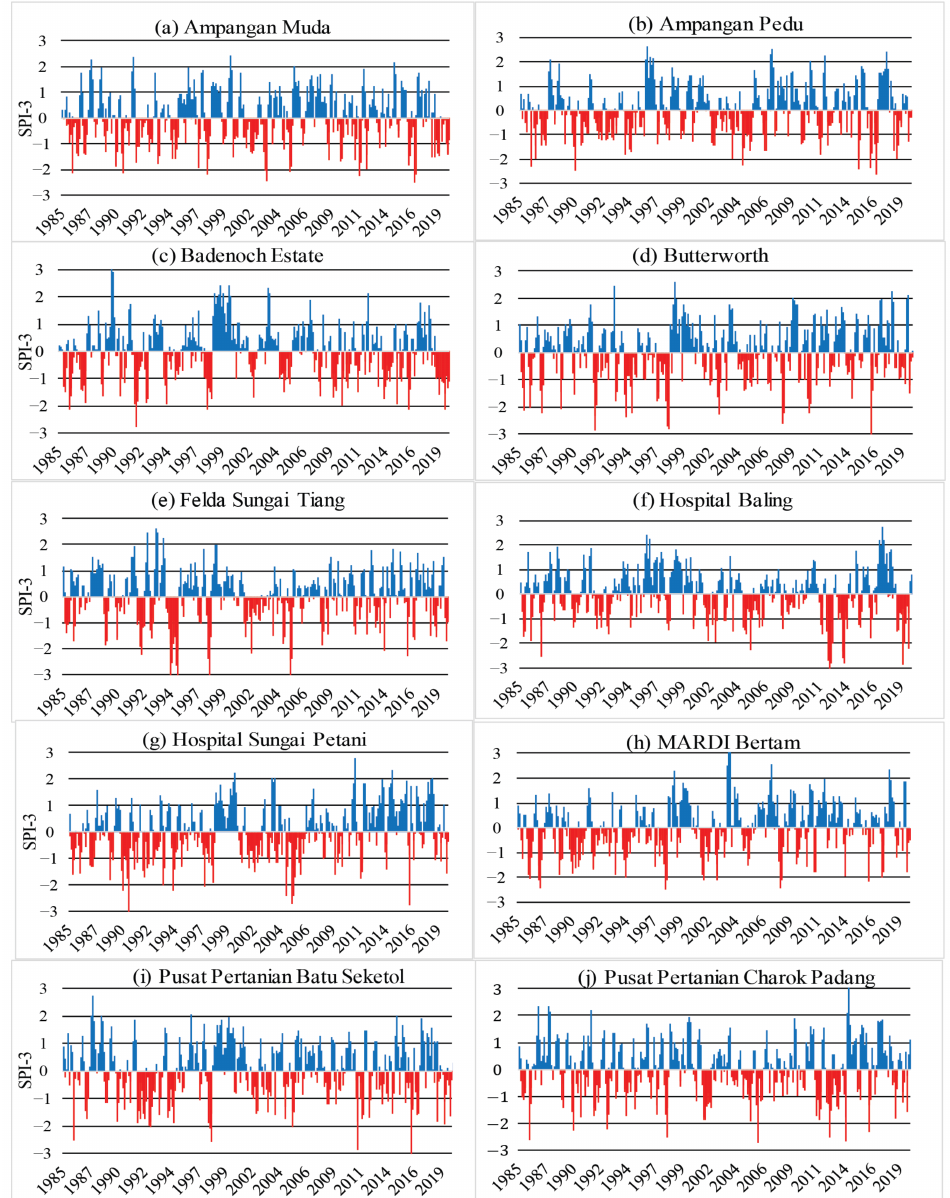
Figure 2. Temporal changes in SPI-3 at the ( a ) Ampangan Muda, ( b ) Ampangan Pedu, ( c ) Badenoch Estate, ( d ) Butterworth, ( e ) Felda Sungai Tiang, ( f ) Hospital Baling, ( g ) Hospital Sungai Petani, ( h ) MARDI Bertam, ( i ) Pusat Pertanian Charok Padang, and ( j ) Pusat Pertanian Batu Seketol stations from 1985 to